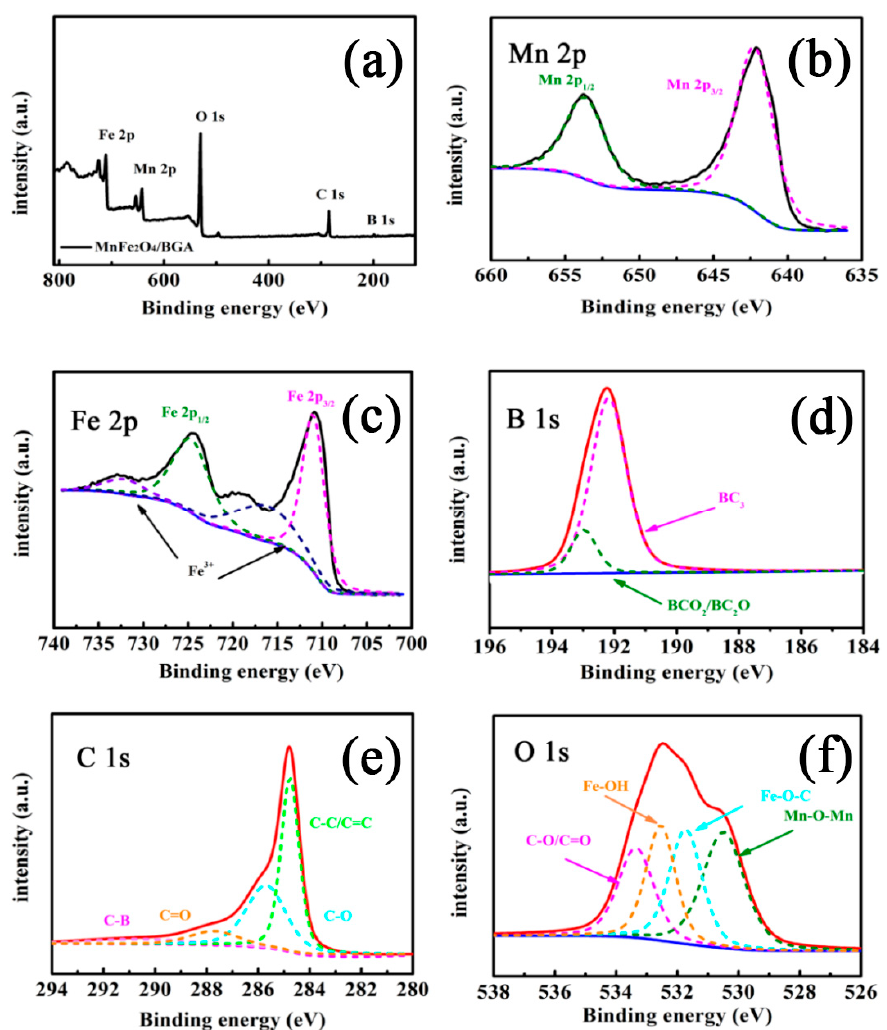
Figure 4. The ( a ) survey and deconvoluted ( b ) Mn 2p, ( c ) Fe 2p, ( d ) B 1s, ( e ) C 1s as well as ( f ) O 1s XPS spectra of the MnFe 2 O 4 /BGA composite. XPS spectra of the MnFe 2 O 4 /BGA